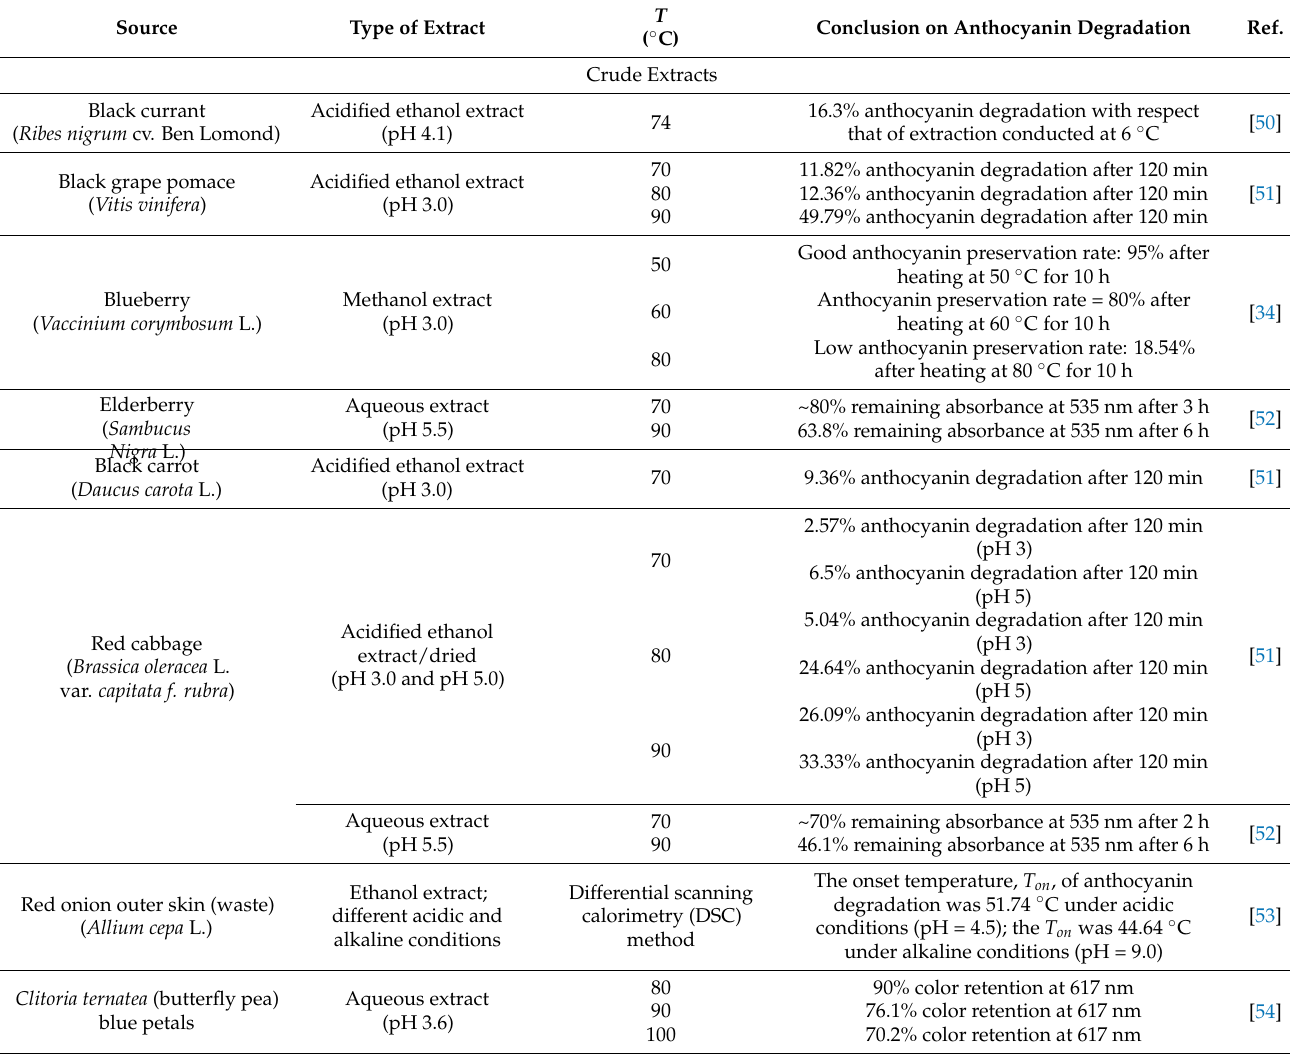
Table 2. Anthocyanin loss (%) in crude and purified extracts subjected to